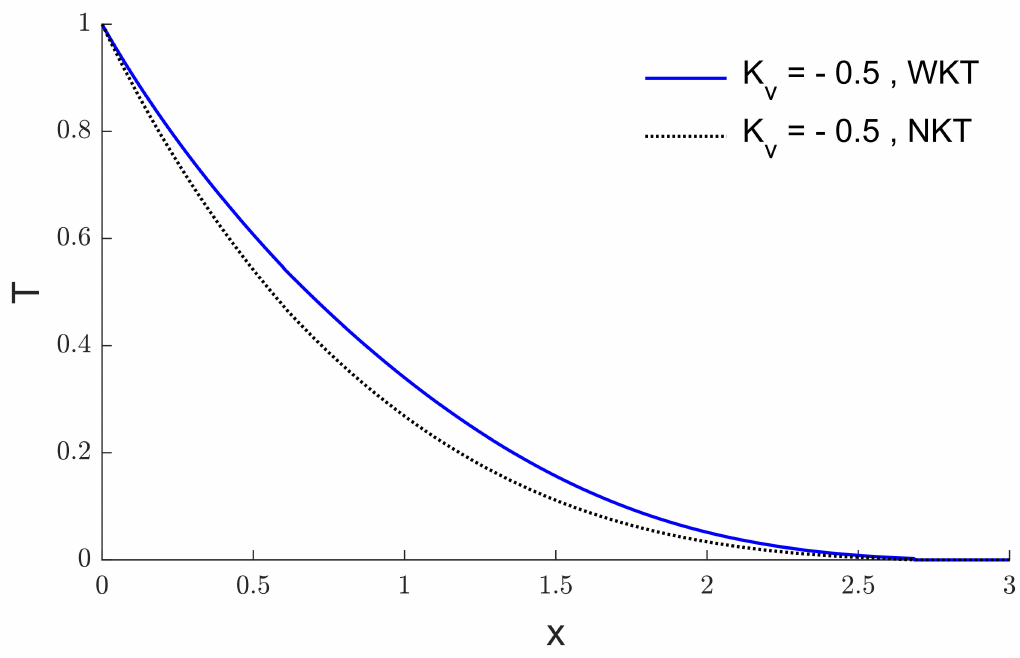
Figure 7. The temperature variations with and without Kirchhoff transform when K v = −